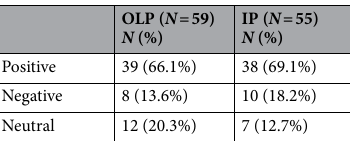
Table 3. Ratings of the open-ended questions. Judgement of the idea regarding the respective interventions. IP imaginary pill, OLP open-label placebo.